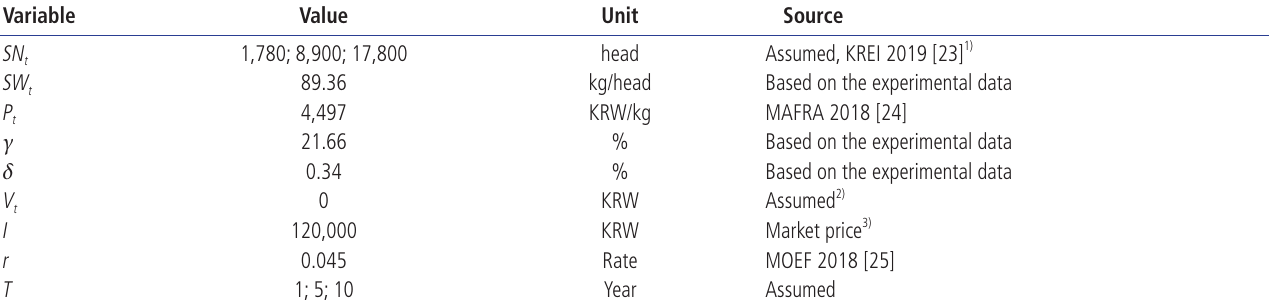
Therefore, the economic benefit, at the farm level, of heating the FMD vaccine can be calculated by 164 Table 1. Summary of the independent variables Variable subtracting Equation 3 from Equation 5, as below. 165